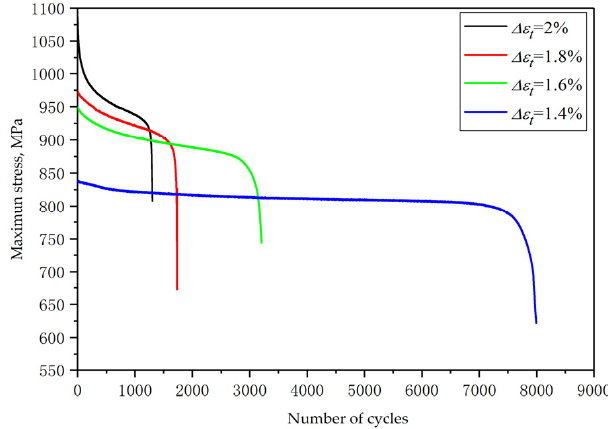
Figure 4. The cyclic stress curves corresponding to different total strain.